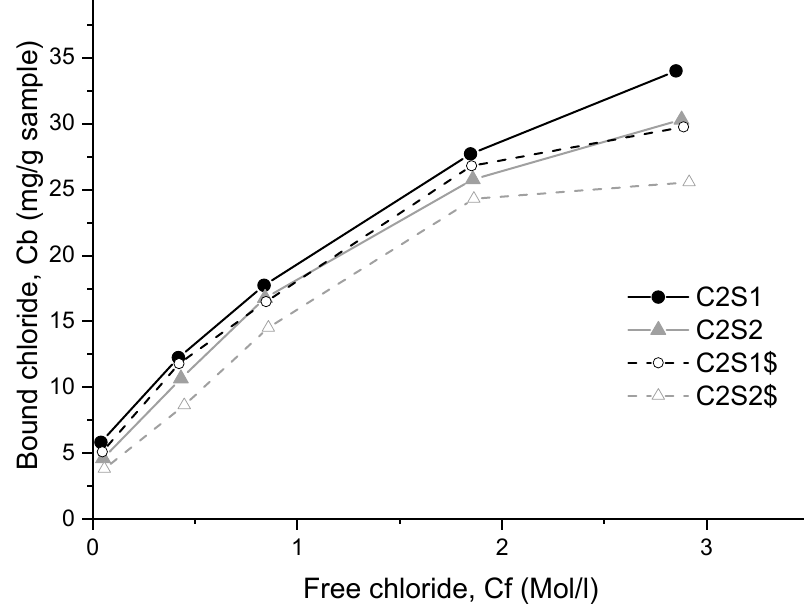
Figure 4. Bound chloride content vs. free chloride content for different slag blends [76].